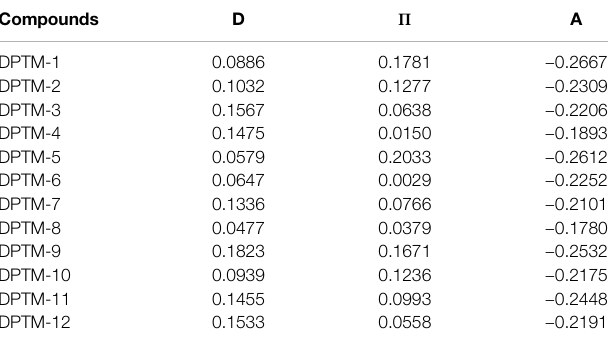
TABLE 5 | The computed ( β total ) and major contributing tensor ( a.u. ) of the investigated compounds (DPTM-1 to DPTM-12). Compounds